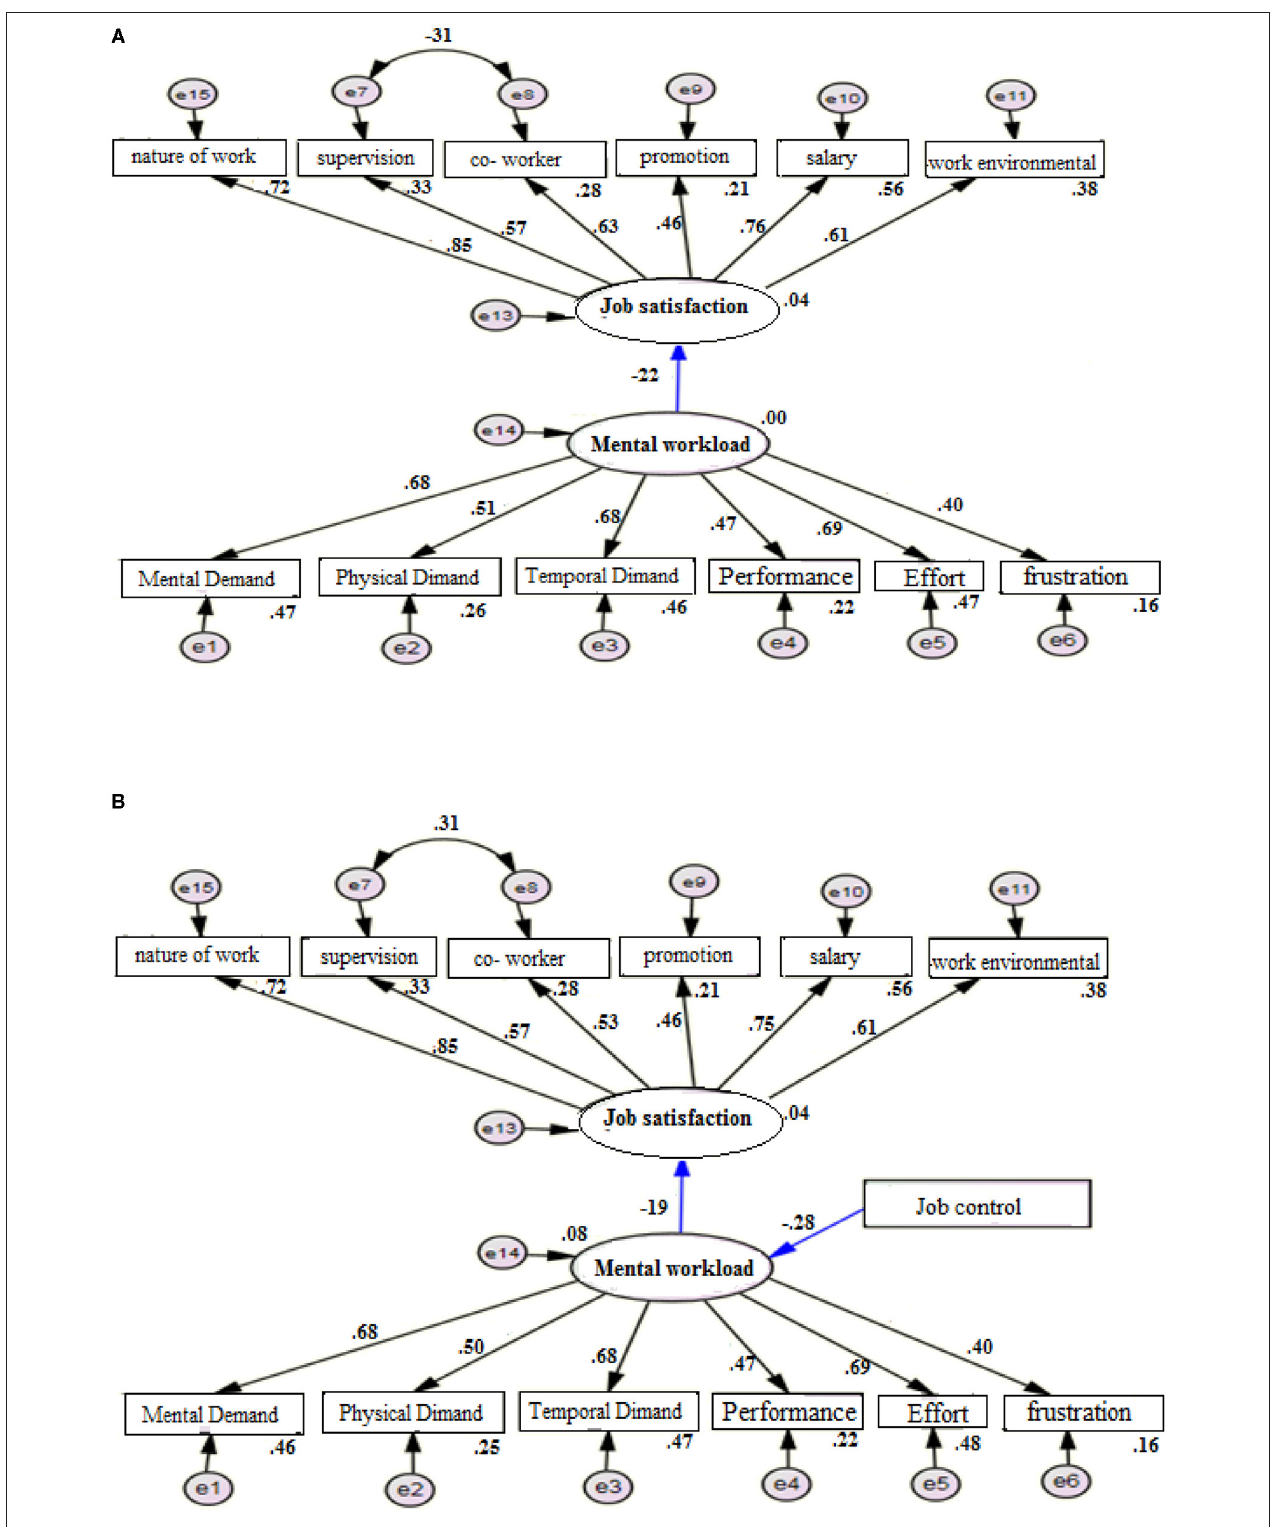
FIGURE 2 | (A) The model of relationship between job satisfaction and mental workload without job control moderating variables. (B) The model of relationship between job satisfaction and workload with moderating variable of job control.